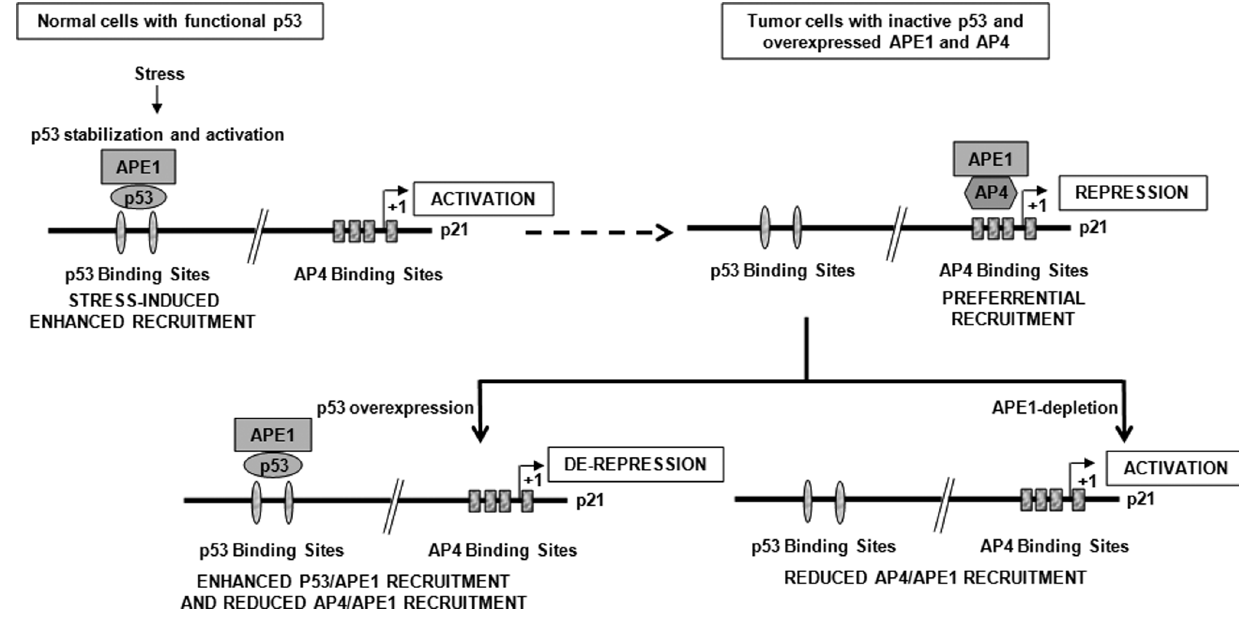
Figure 7. A model for crosstalk between APE1 with p53 and AP4 in p21 gene regulation.